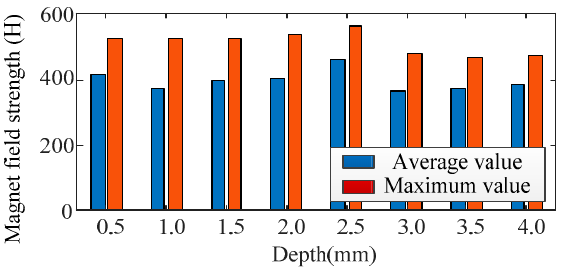
Figure 11. Maximum and average values of magnetic field strength due to the fringe effect with different depths.